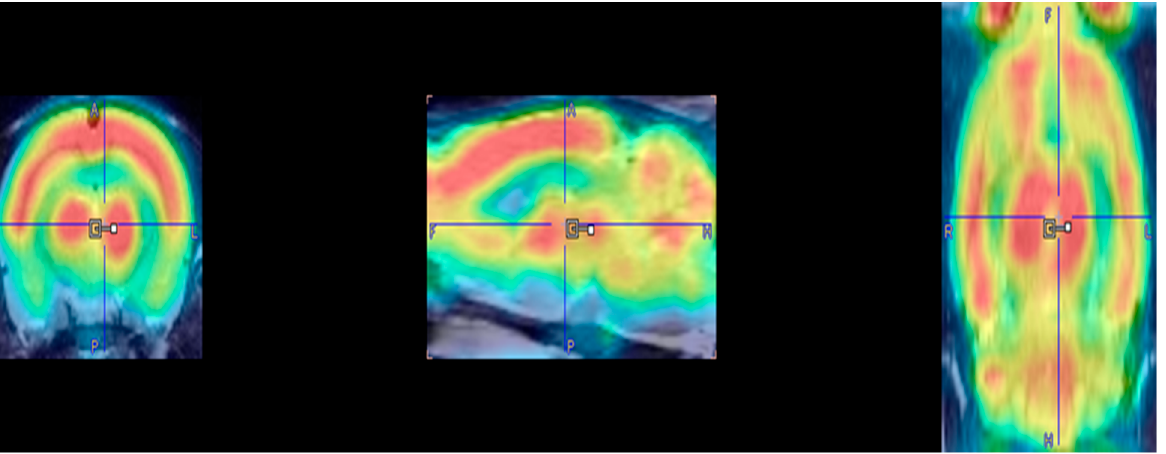
Figure 2. PET Images: Representative examples of a reconstructed PET image superimposed on an MRI template: coronal, sagittal, and horizontal (left to right). MRI template: coronal, sagittal, and horizontal (left to